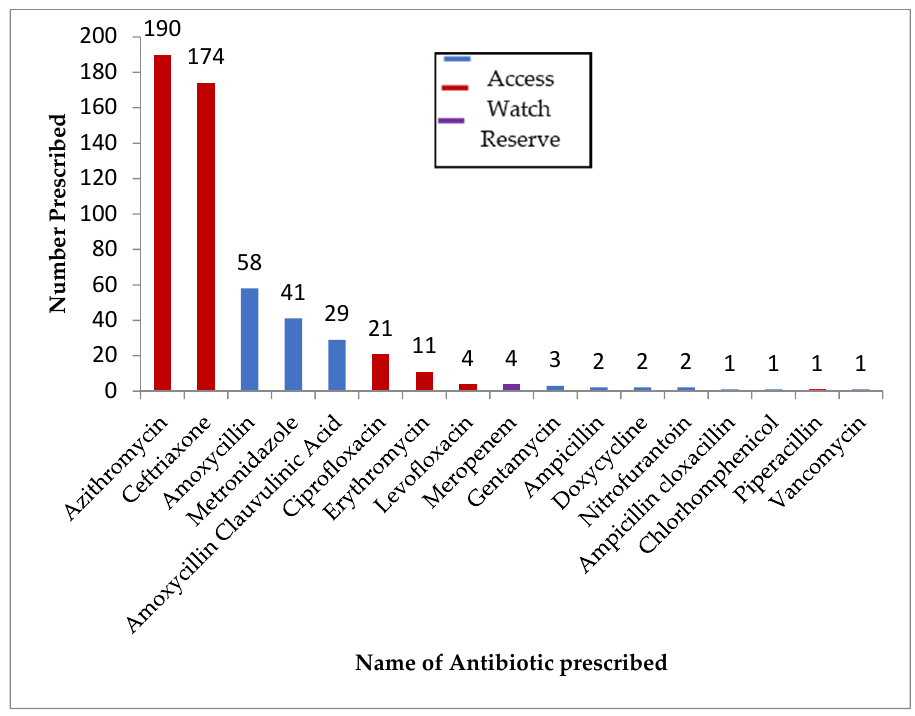
Figure 2. Different antibiotics prescribed to COVID-19 confirmed patients admitted to community care and treatment centres in Sierra Leone, March 2020–March 2021 (N = 545). Table 3. Prevalence of antibiotic use and its associated factors among people with confirmed COVID- 19 infection admitted in community care centres and treatment centres of Sierra Leone, March 2020– March 2021 ( N =